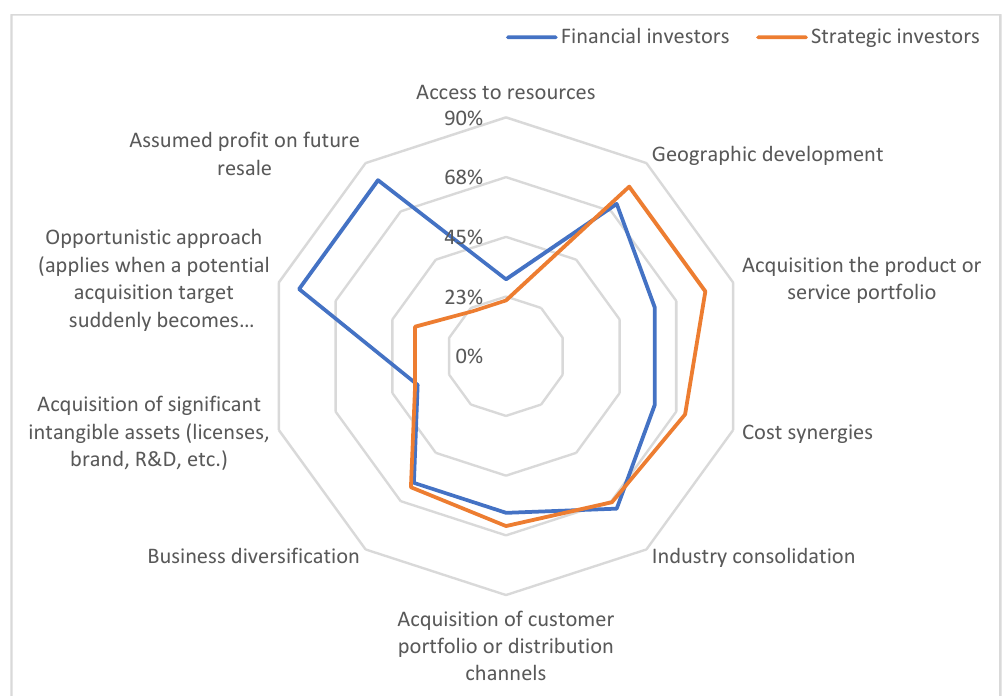
Figure 9. Main investment motives in mergers and acquisitions. Source: author’s study based on report “Charakterystyka procesów transakcyjnych w Polsce. Oczekiwania a rzeczywisto ść ”, KPMG, Warszawa 2021, p. 13.